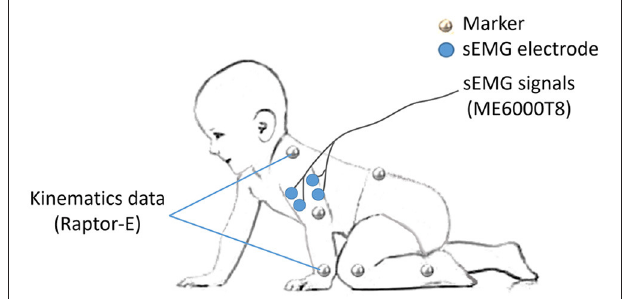
FIGURE 1 | Experiment setup of markers and sEMG